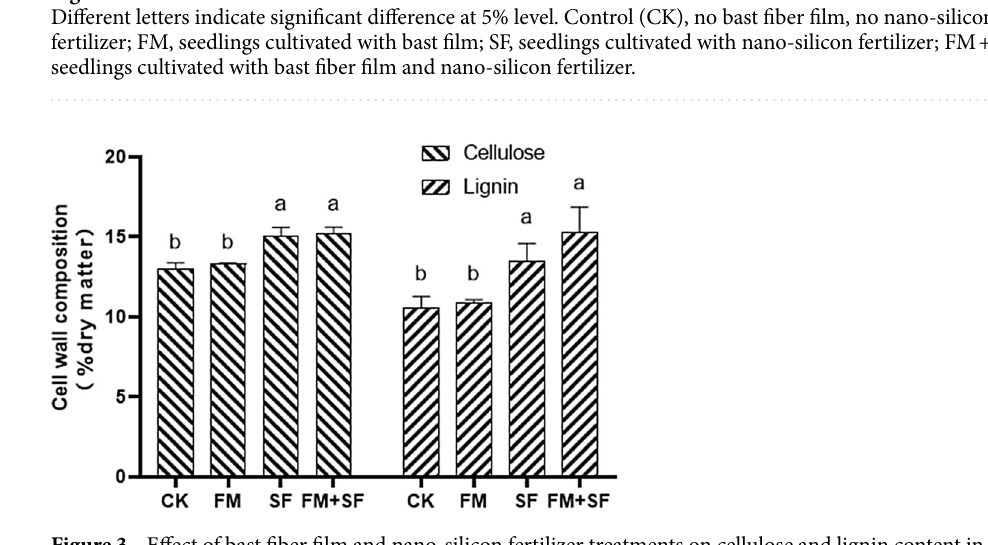
Figure 3. Effect of bast fiber film and nano-silicon fertilizer treatments on cellulose and lignin content in rice stalks. Different letters indicate significant difference at 5% level. Control (CK), no bast fiber film, no nano- silicon fertilizer; FM, seedlings cultivated with bast film; SF, seedlings cultivated with nano-silicon fertilizer; FM + SF, seedlings cultivated with bast fiber film and nano-silicon